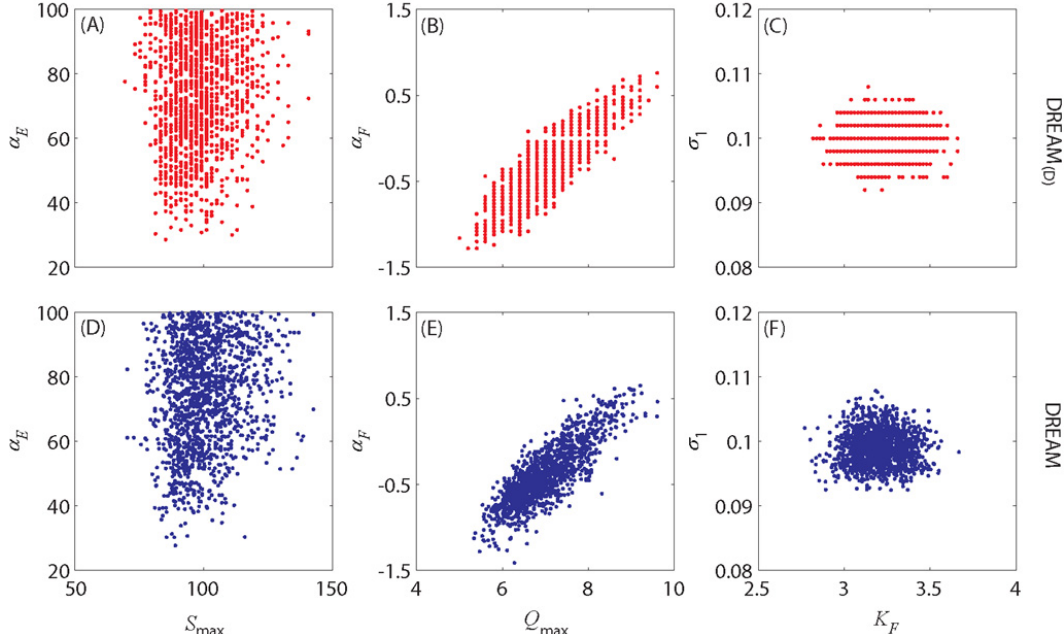
Fig. 8. Two-dimensional scatter plots of the DREAM ( D ) derived posterior samples (top panel: red), and corresponding bivariate samples estimated with DREAM (bottom panel: blue). Only a few parameter pairs are shown as this is sufficient to illustrate the similarity of the sampled distributions.